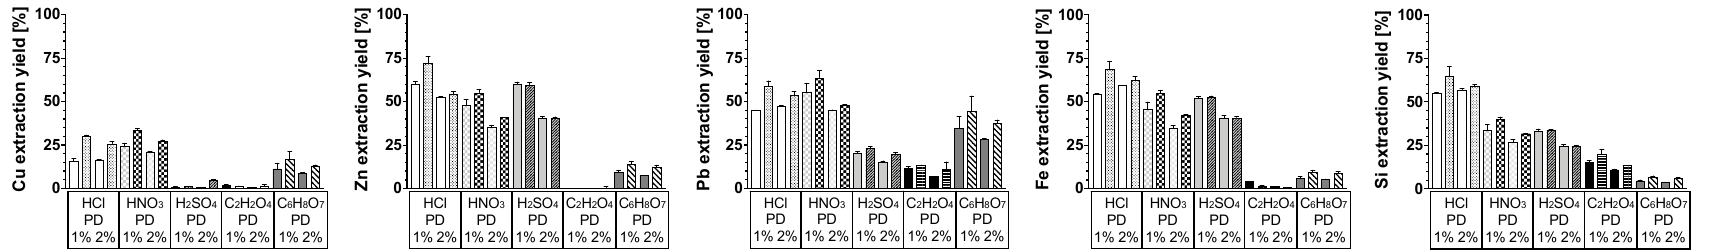
Figure 3. Chemical extraction of metals from crystalline slag treated with normality equivalent (2 N) acids at various pulp densities (1–2%).